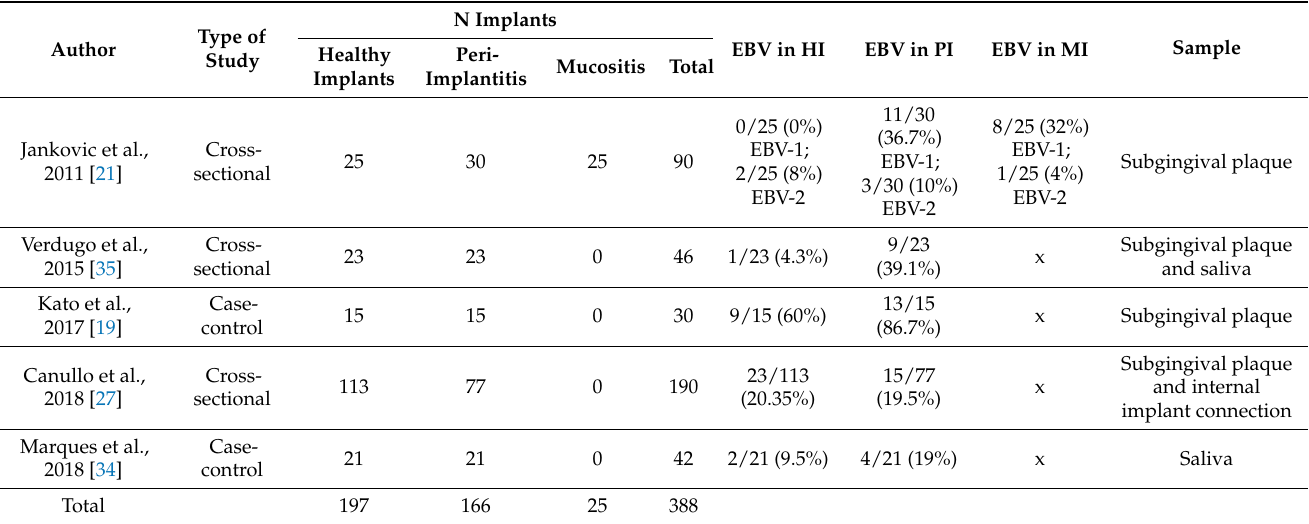
Table 1. Summary of the included studies.